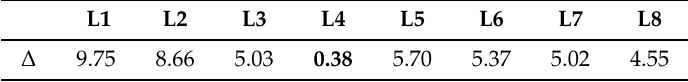
Table 6. Mahalanobis Distances Computed for the Association of Corner L9 of Figure 12. L1 L2 L3 L4